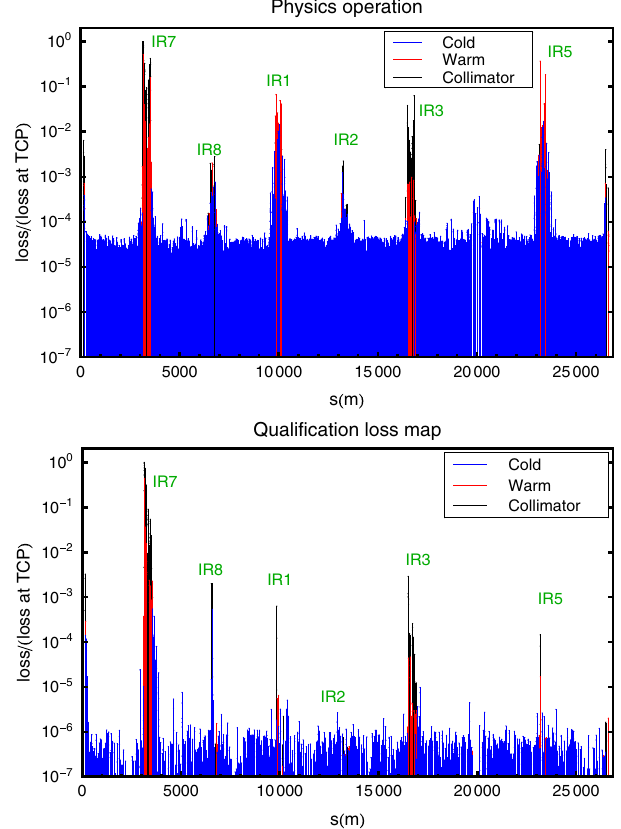
FIG. 5. Examples of beam loss distribution around the LHC, measured with the BLMs using a 1.3 s integration time, from physics operation on August 17, 2011 (top) and from a quali- fication loss map of the betatron collimation system on March 11, 2011 (bottom). Here losses were provoked in B1 by crossing the third-order resonance in the horizontal plane. The physics loss distribution was measured 10 min after the start of stable beams in fill number